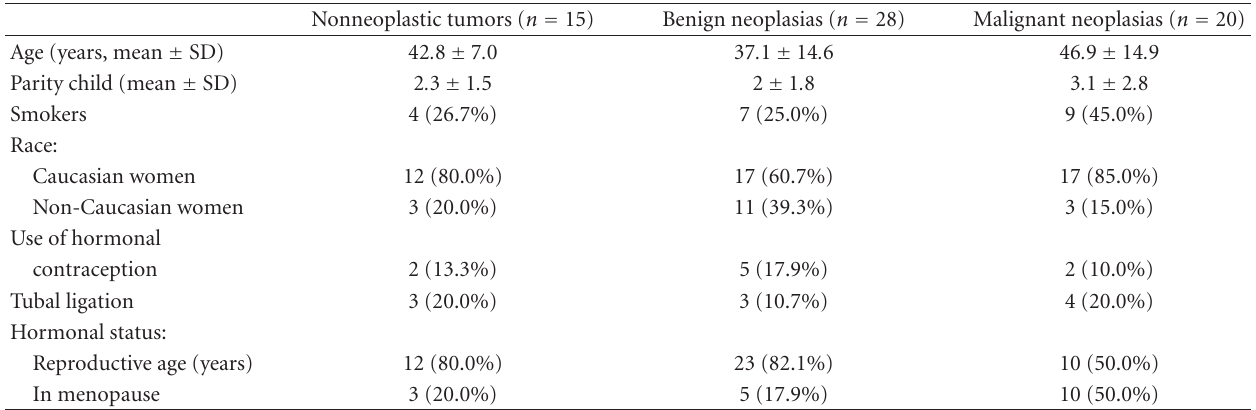
Table 1: Characteristics of the three-patient groups compared in this study.